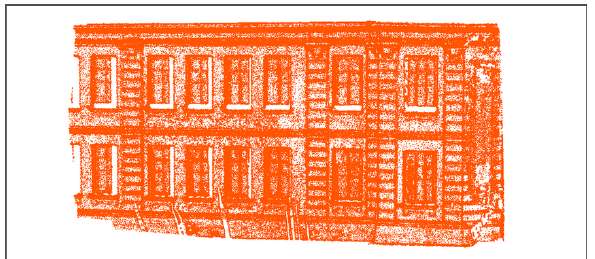
Figure 12 . The denser laser point cloud for evaluation. Absolute distances between the laser point cloud and the generated dense point clouds are compared and analyzed, which are shown in Figure 13. Figure 13(a) shows the comparing results of the final dense point cloud expanding by the proposed method. To make a fair comparison, it doesn’t consider the initial laser point cloud merged here. It can be concluded that 84.92% and 75.22% of the point-to-point distances for the proposed method and the traditional method are less than 0.03 meters, respectively.